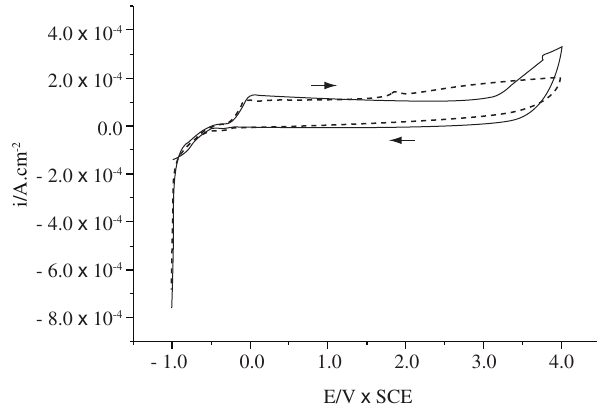
Figure 2. Voltammetric curves of Ti (—) and Ti6Al4V ( … ) in citric acid, between - 1.0 and 4.0 V at 0.02 Vs -1 .